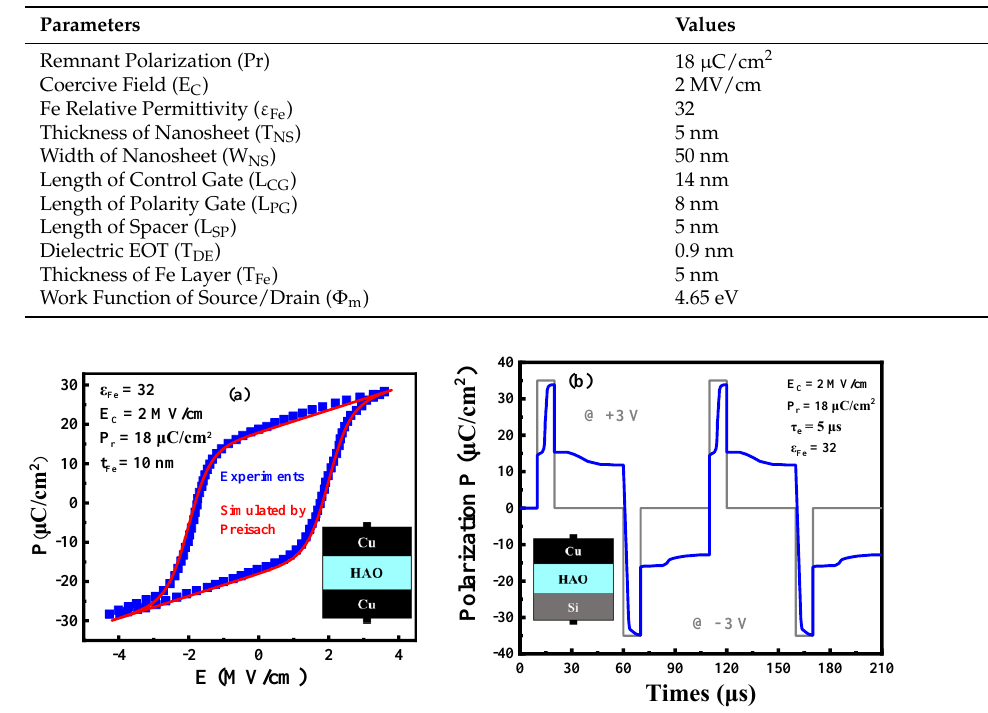
Table 1. Device parameters for Fe-ED NSTFET.